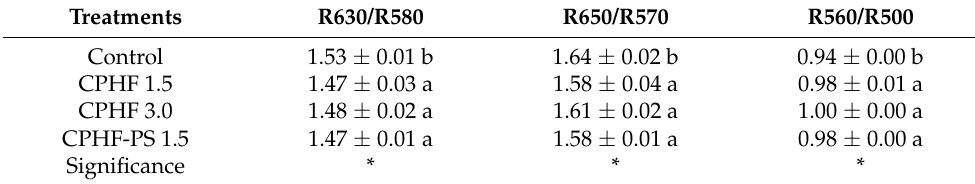
Table 4. Reflectance ratios R630/R580, R650/R570, and R560/R500 in frankfurter samples. Treatments